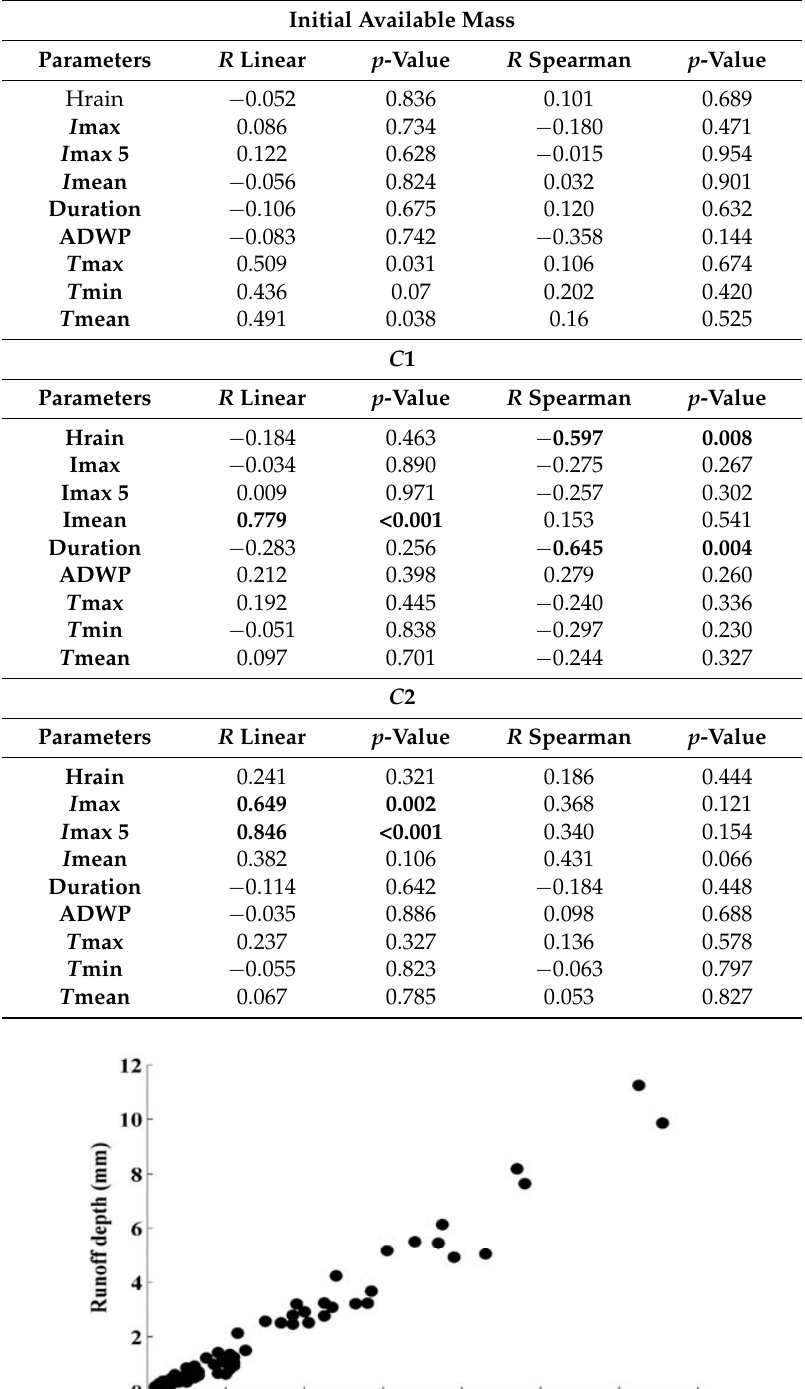
Table A1. Pearson and Spearman Correlations and their corresponding p -values.